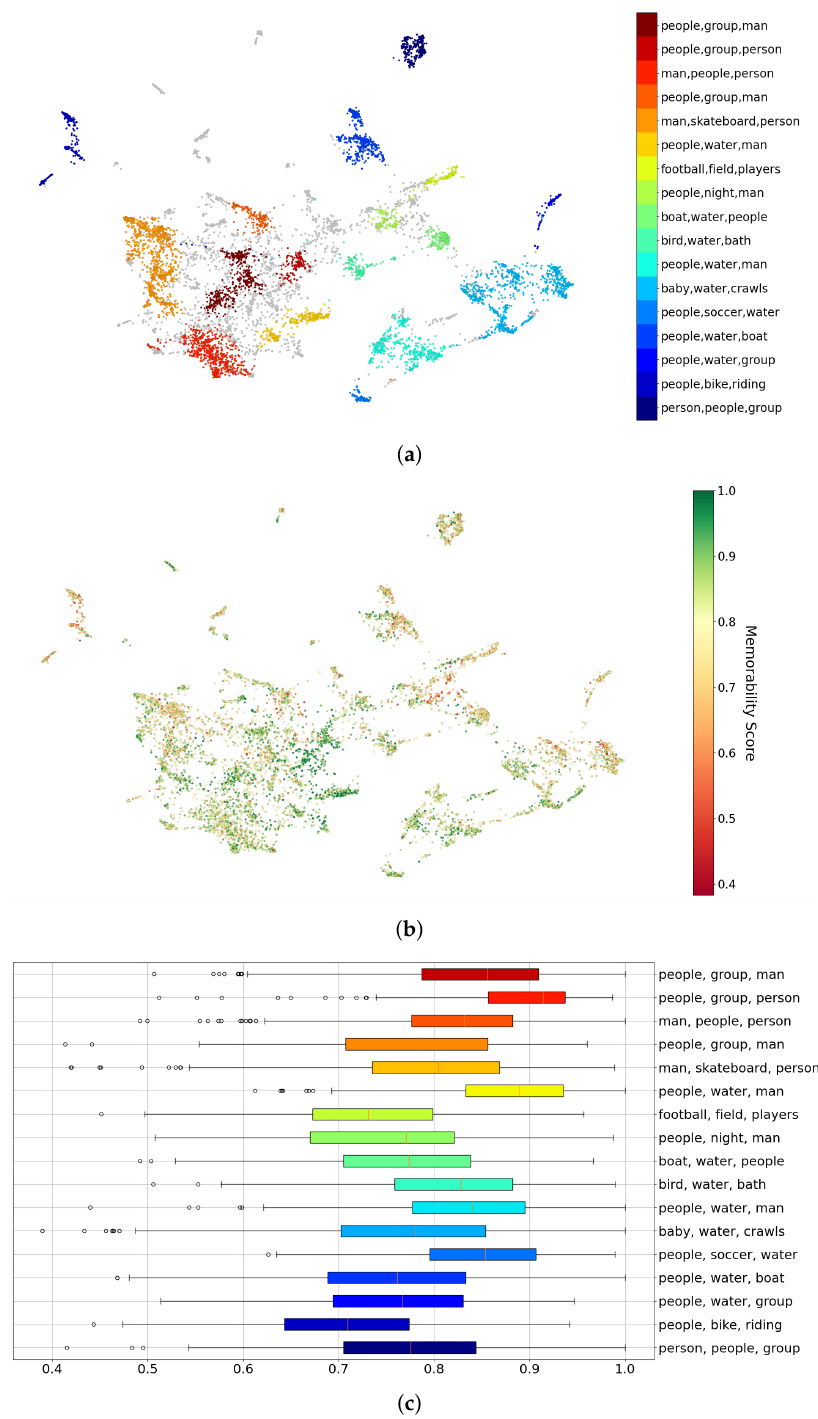
Figure 5. Automatic topic discovery from Sentence-BERT vector embeddings in the Memento10K dataset under an early AVG strategy. Topics found appear mainly targeted at human actions. ( a ) Memento10K’s topics detected from the early AVG scheme. ( b ) Samples shown in color according to their memorability score. ( c ) Distribution of memorability scores within each detected